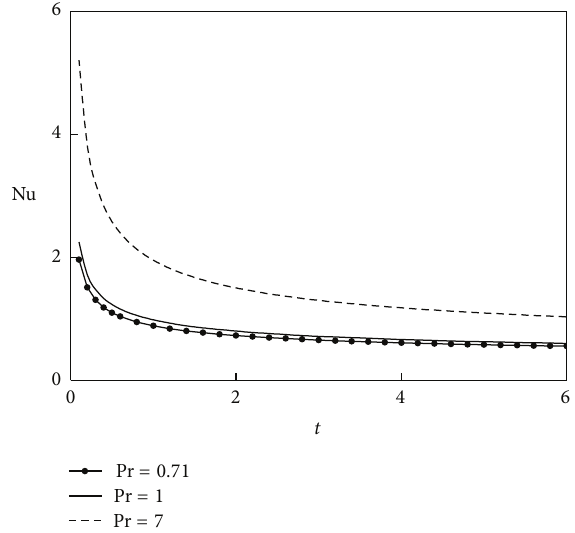
Figure 11: Effects of Pr on the Nusselt number with respect to time.